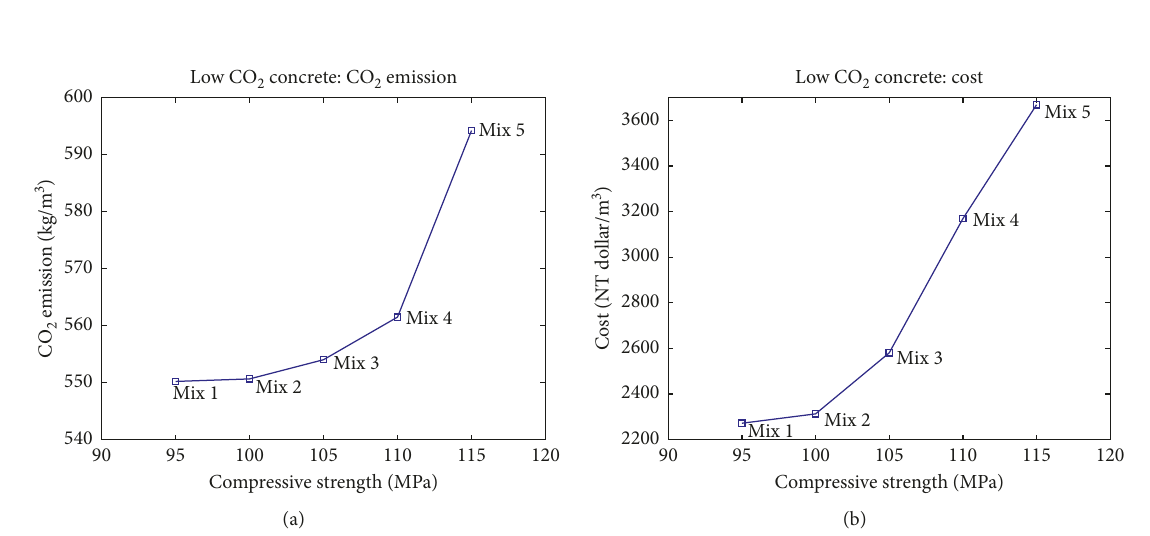
Figure 1: (a) CO 2 emissions of low-CO 2 concrete. (b) Cost of low-CO 2 concrete.